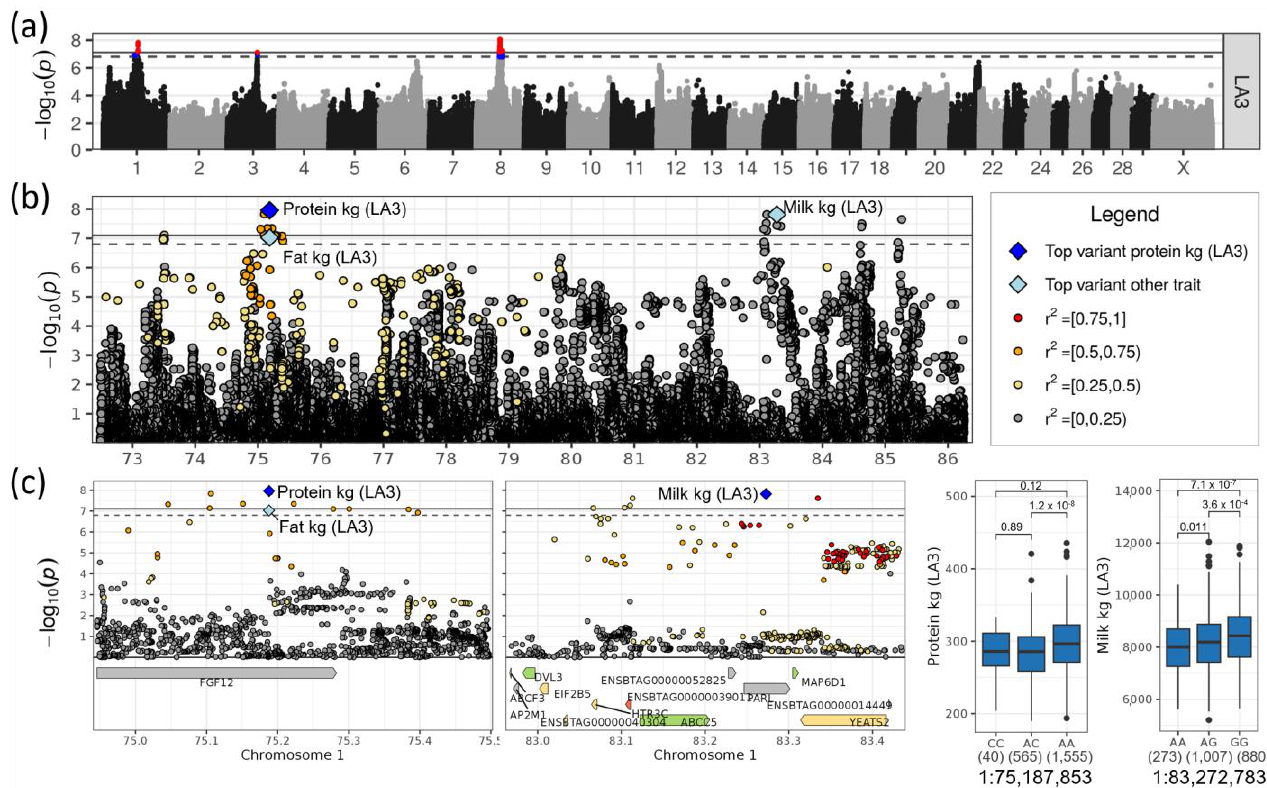
Figure 3. ( a ) Manhattan plot for milk yield in LA3. Suggestive ( p < 0.1, dashed line) and significant ( p < 0.05, solid line) associations are highlighted in blue and red, respectively. ( b ) Regional association plot for the QTL on chromosome 1. ( c ) Zoomed regional association plot including genes and effect plots for top SNPs for protein and milk yield in LA3. Genes containing variant(s) with low, moderate or high impact are colored green, yellow and orange, respectively, and are otherwise grey.